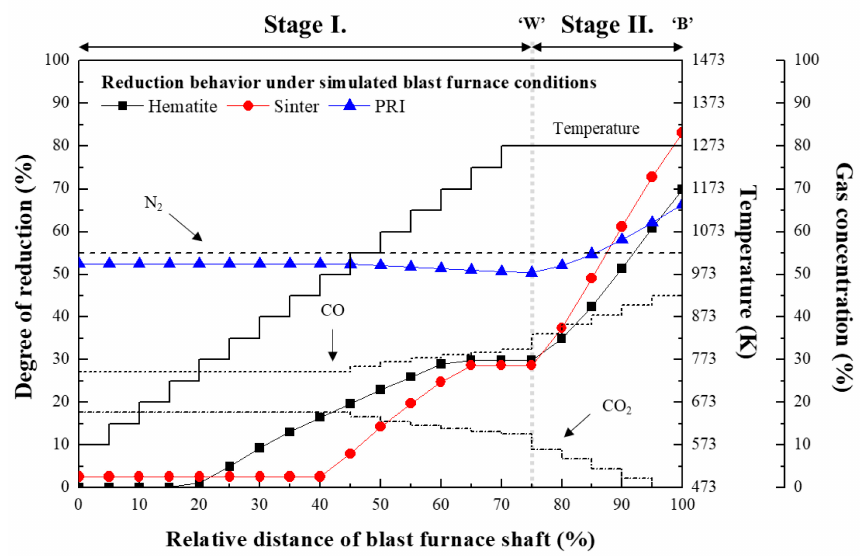
Figure 9. Reaction behaviour of hematite, sinter, and PRI under the simulated blast furnace condi- tions.